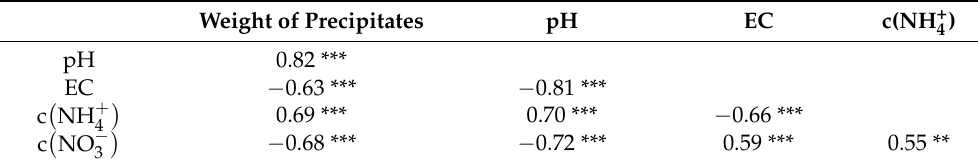
Table 1. Correlation among the weight of the precipitates and physicochemical properties.